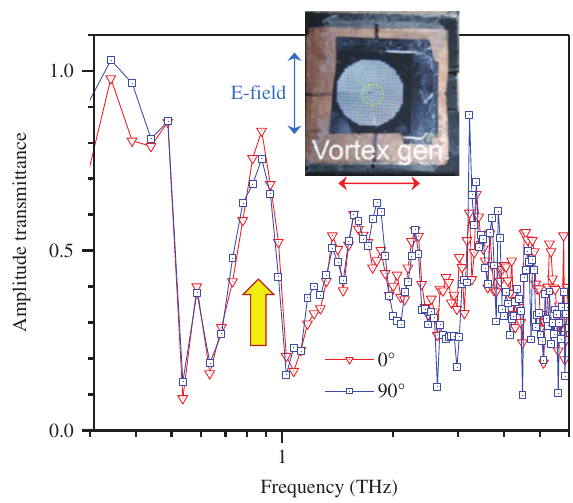
Figure 7: Transmission of the Si metasurface vortex generator. The peak is at 0.83 THz (arrow marker), which is close the designed 0.78 THz. The deviation is due to the slight mismatch between the simulated and fabricated dimensions of the